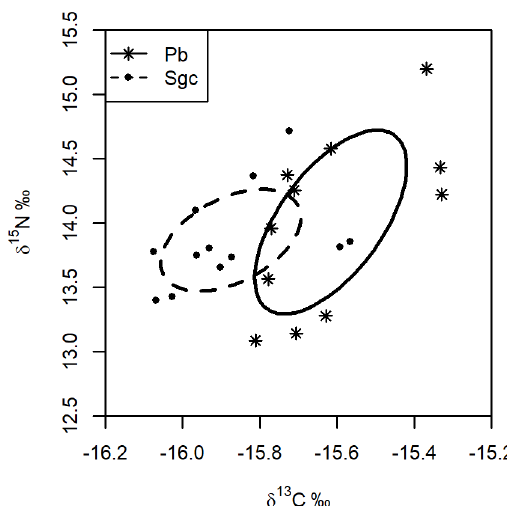
Figure 3. Scatter plot of the δ 13 C and δ 15 N values (δ-space) of franciscana dolphins (Pb) and coastal Guiana dolphins (Sgc). Each dot represents an individual and each ellipse represents 40% of the samples of each species using the SEAc statistic.